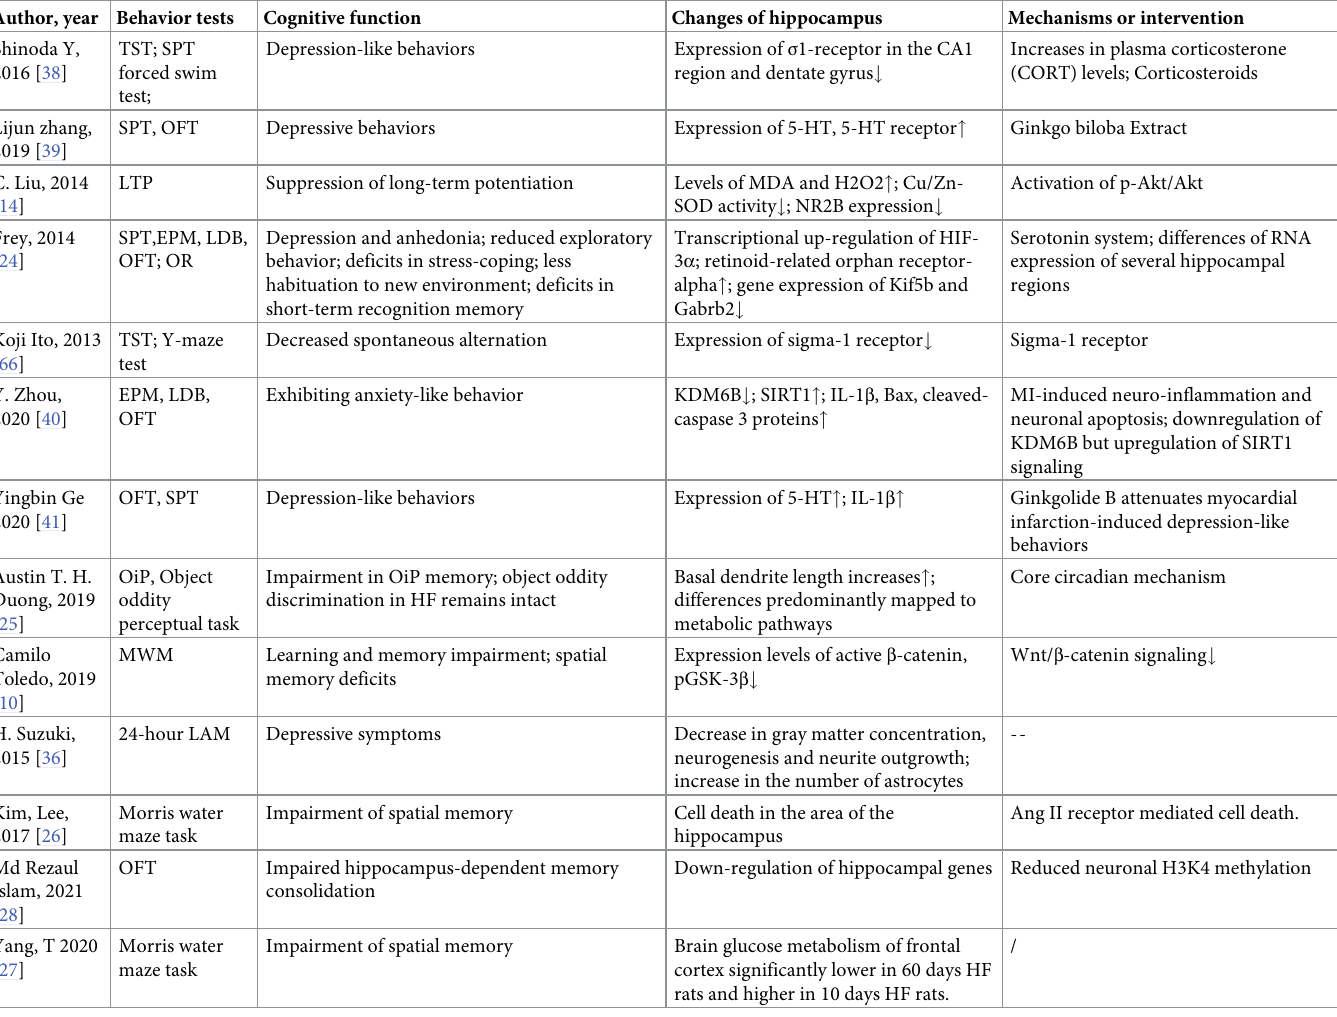
Table 7. Characteristics of cognitive function and hippocampal and frontal lobe changes of HF rats in included experimental